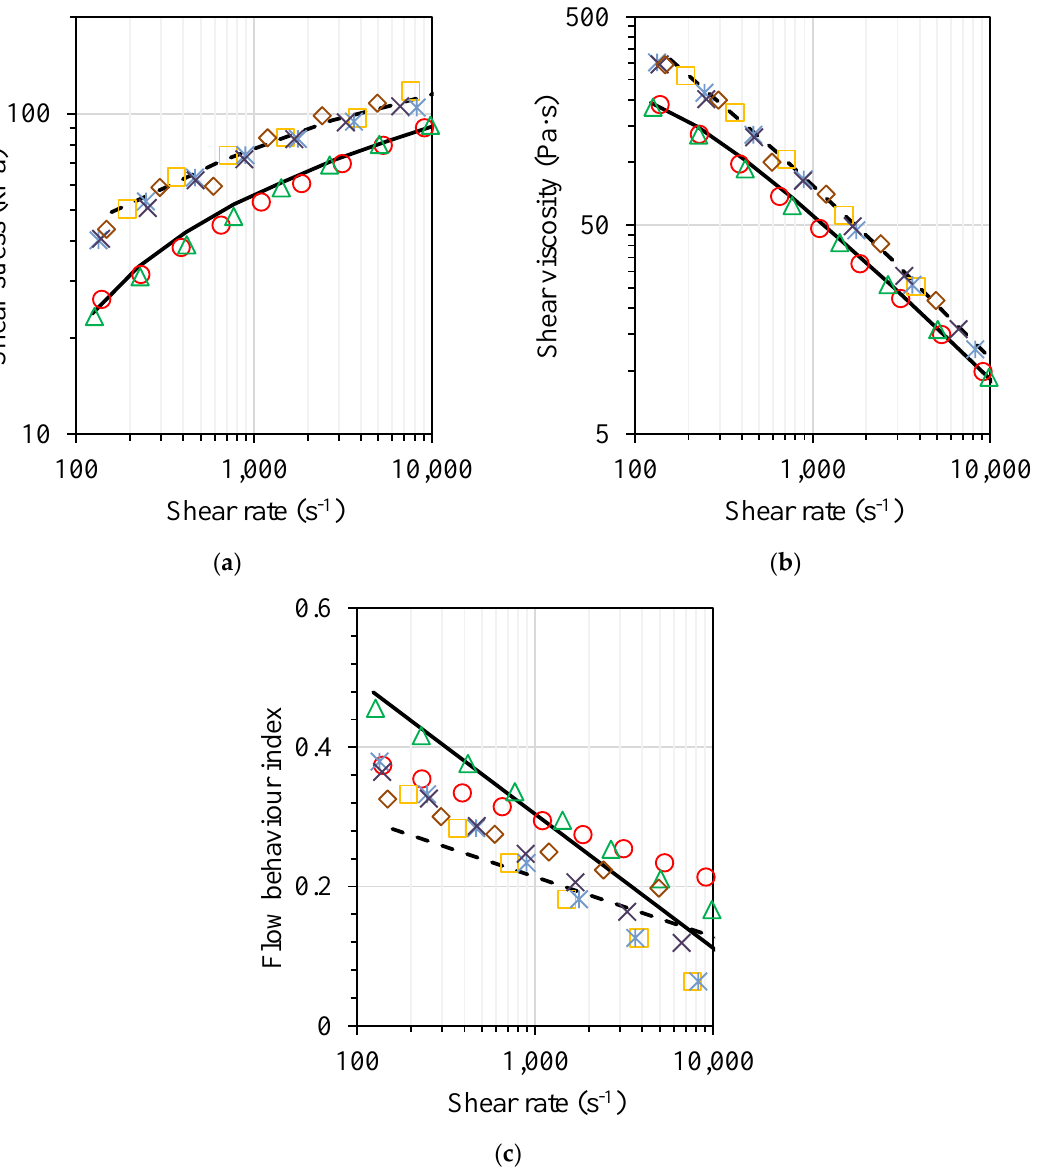
Figure 5. Shear stress ( a ), shear viscosity ( b ), and flow behaviour index ( c ) of PP (solid line), PP composite with SH (dashed line), PP nanocomposites with 5 wt.% of C ( ○ ) or M (Δ), PP hybrid composites with SH and 1 wt.% of C (□) or M (ж) , and PP hybrid composites with SH and 3 wt.% of C (◊) or M (×) as functions of shear rate.